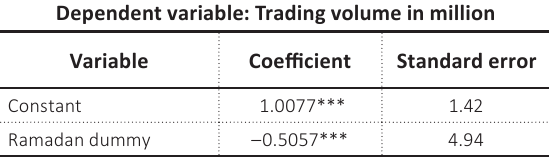
Table 3. OLS regression (3) estimation results